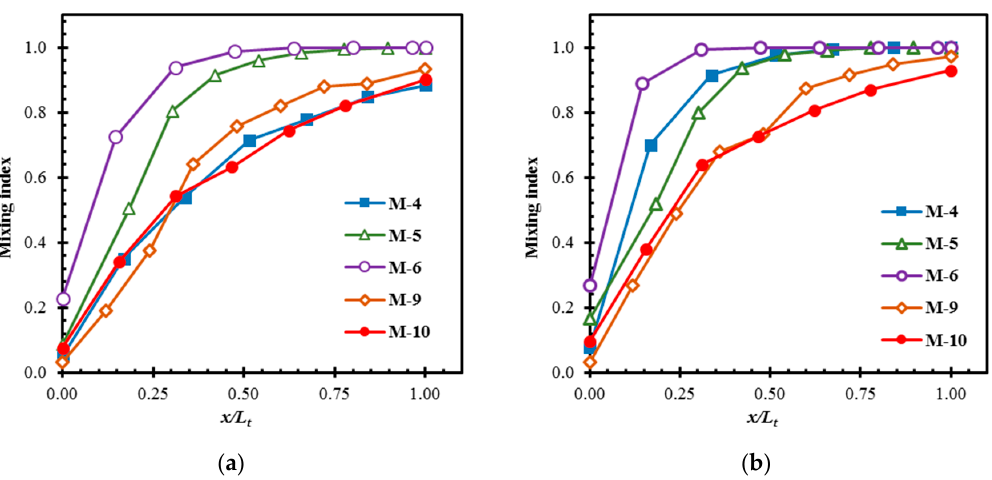
Figure 13. Developments of mixing along the length of the micromixers: ( a ) Re = 20 and ( b ) Re = 40.